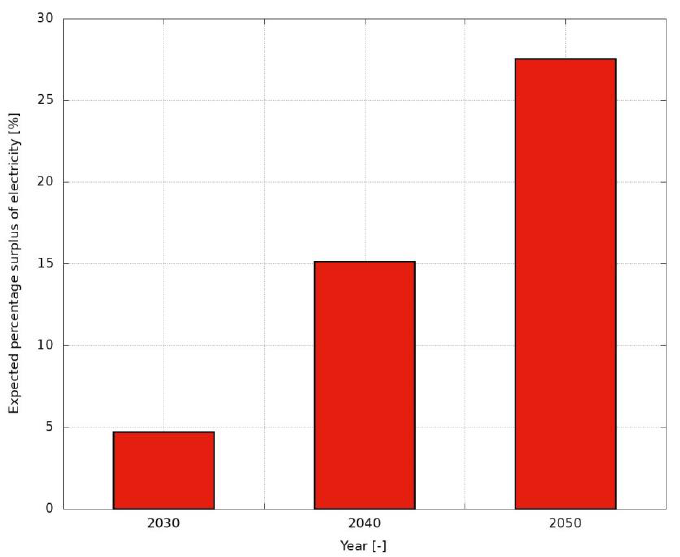
Figure 12. Expected percentage surplus of electric energy to be produced per year with respect to the current electric energy production in Italy (2021).